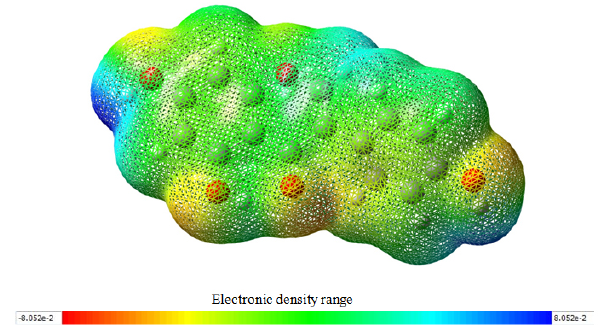
Fig. 7. The molecular electrostatic potential (MEP) graph of genistein . The potential of the blue, green, and red regions of the molecular electrostatic potential (MEP) graph of genistein is positive, zero, and negative, respectively.